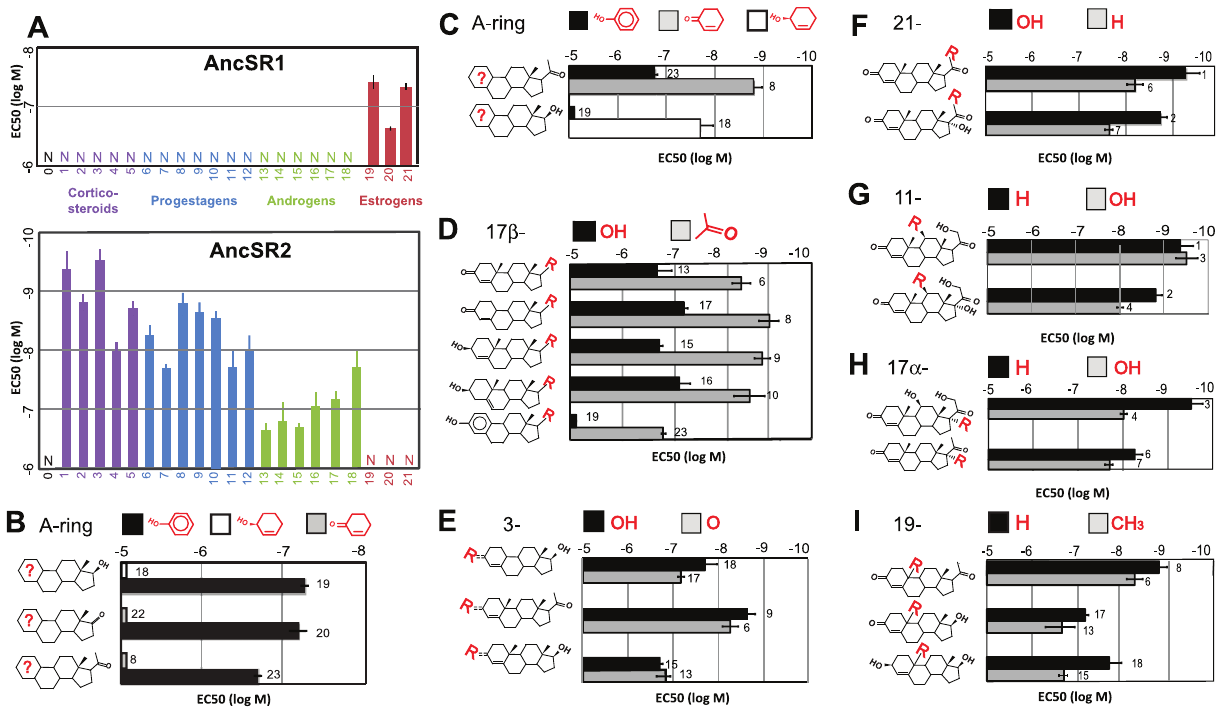
Figure 2. Ligand-recognition rules of AncSR1 and AncSR2. A, The sensitivity of AncSR1-LBD (top panel) and AncSR2-LBD (bottom panel) to various hormones (Table S4) was characterized in a triplicate luciferase reporter assay and is displayed as EC50, the concentration at which half- maximal reporter activation is achieved. Error bars, 95% confidence interval. Sets of hormones are grouped by color and are numerically labeled according to the list below. B, AncSR1’s ligand recognition criteria. Each pair of bars shows the EC50 of AncSR1 to a pair of hormones that differ only by aromatization of the A-ring (shown in red on the ligand structure and in the key). Unlike aromatization, substitution of a 17-keto or acetyl for estradiol’s hydroxyl has only a weak effect on sensitivity, as shown by the small differences among pairs. C-I, AncSR2’s ligand recognition criteria. Each pair of bars shows the sensitivity of the receptor to hormones that differ only in the functional group at specified positions or aromatization of the A- ring. Bar labels indicate the substance tested: 0, cholesterol, 1, 11-deoxycorticosterone, 2, 11-deoxycortisol; 3, corticosterone; 4, cortisol; 5, aldosterone; 6, progesterone; 7, 17 a -hydroxyprogesterone; 8, 19-norprogesterone; 9, 4-pregnenolone; 10, 5-pregnenolone; 11, 20 a hydroxypro- gesterone; 12, 20 b hydroxyprogesterone; 13, testosterone; 14, dihydrotestosterone; 15, 4-androstenediol; 16, 5-androstenediol; 17, 19- nortestosterone; 18, bolandiol; 19, estradiol; 20, estrone; 21, estriol; 22, 4-androstenedione; 23, 19-nor-1, 3, 5(10)-pregnatriene-3-ol-20-one (NPT).